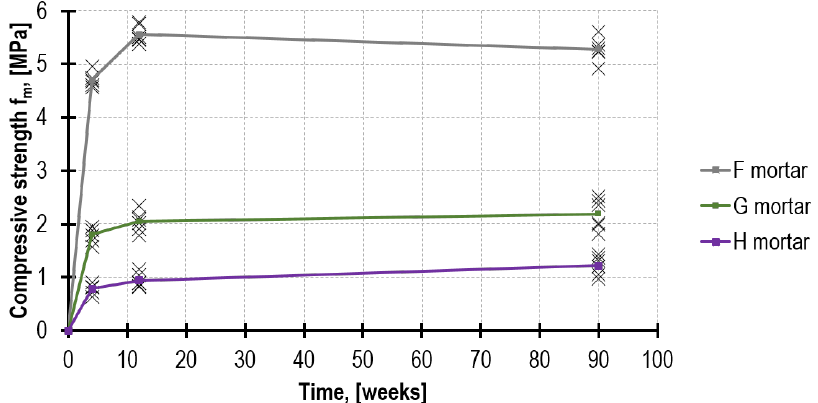
Figure 8. Compressive strength development in time.